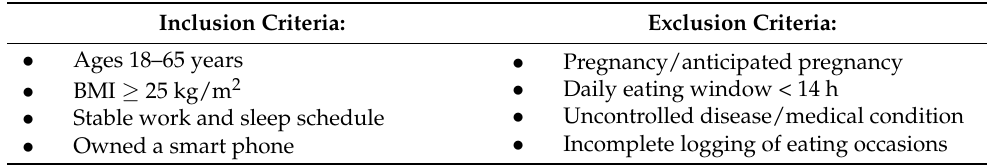
Table 1. Summary of inclusion and exclusion